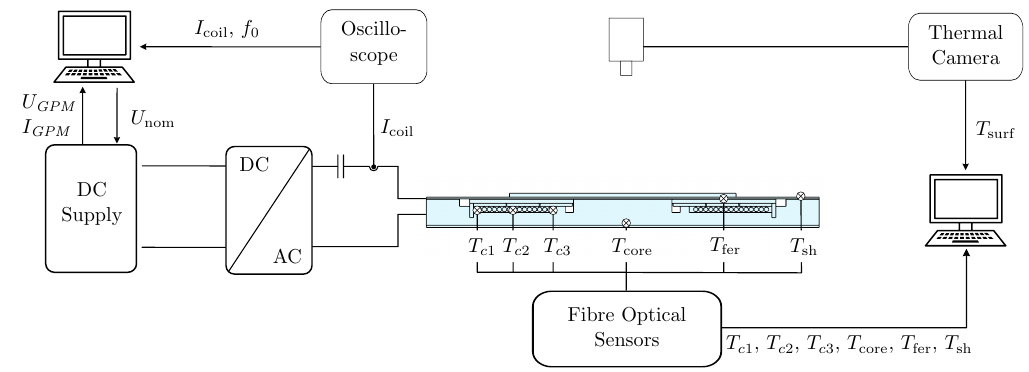
Figure 9. Experimental setup of the thermal analysis and position of the fibre optical thermal sensors exemplary on sandwich